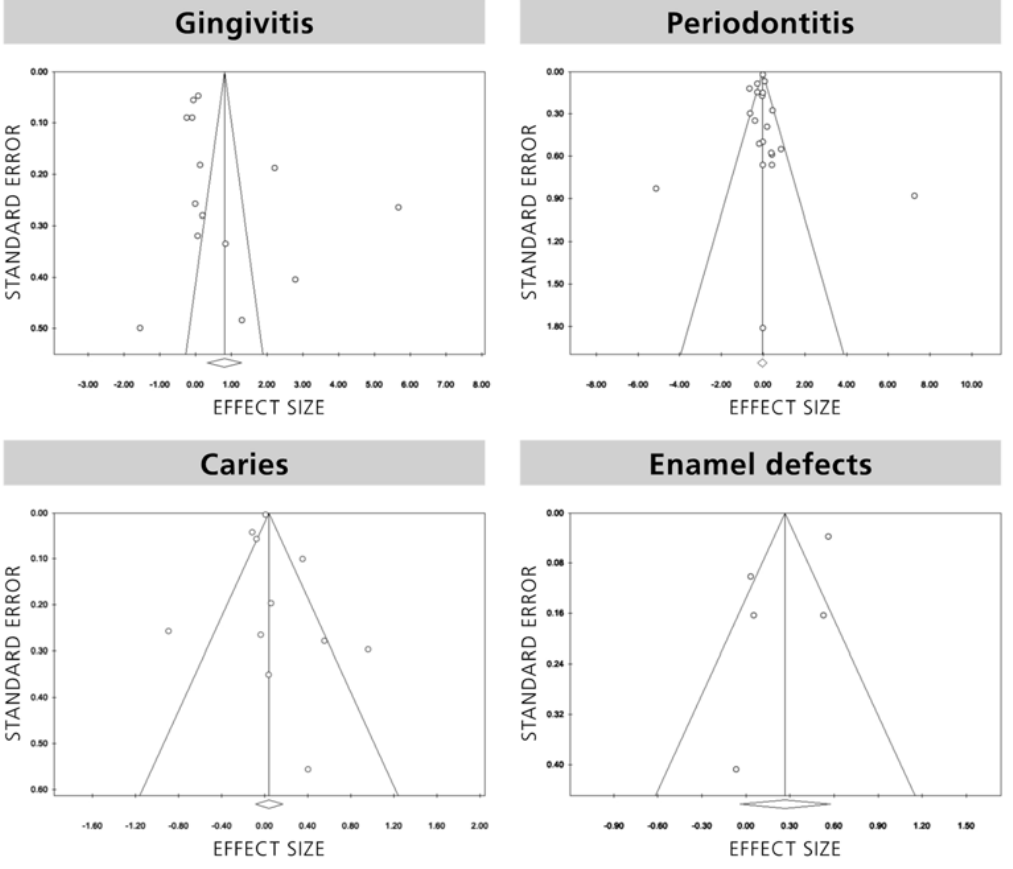
Figure 2. Funnel plots of publication bias.